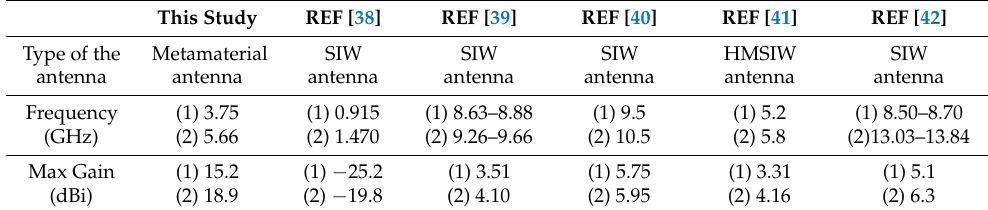
Figure 15. The measured radiation performance of antenna with different cavity thickness: ( a )|S 11 |; ( b ) realized gain. Table 3. Dual-band antennas performance comparison.